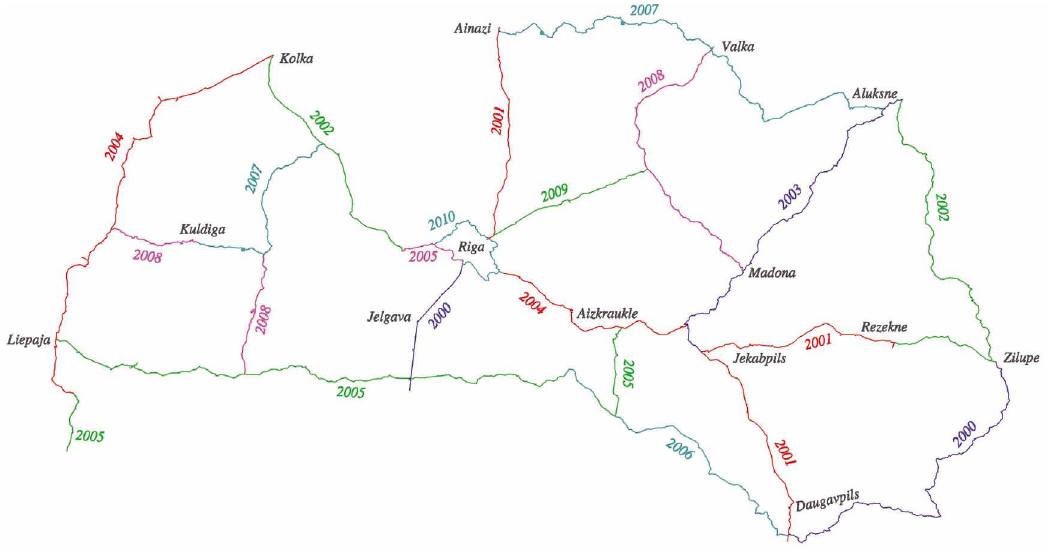
Fig. 1. The first order levelling lines of the Latvian NFOLN and years of field